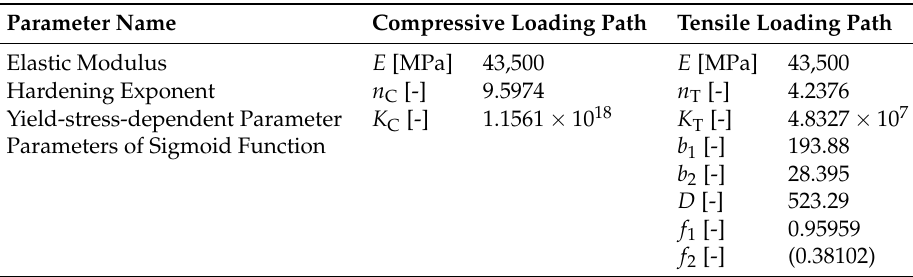
Table 1. Parameters of the tensile and compressive loading path